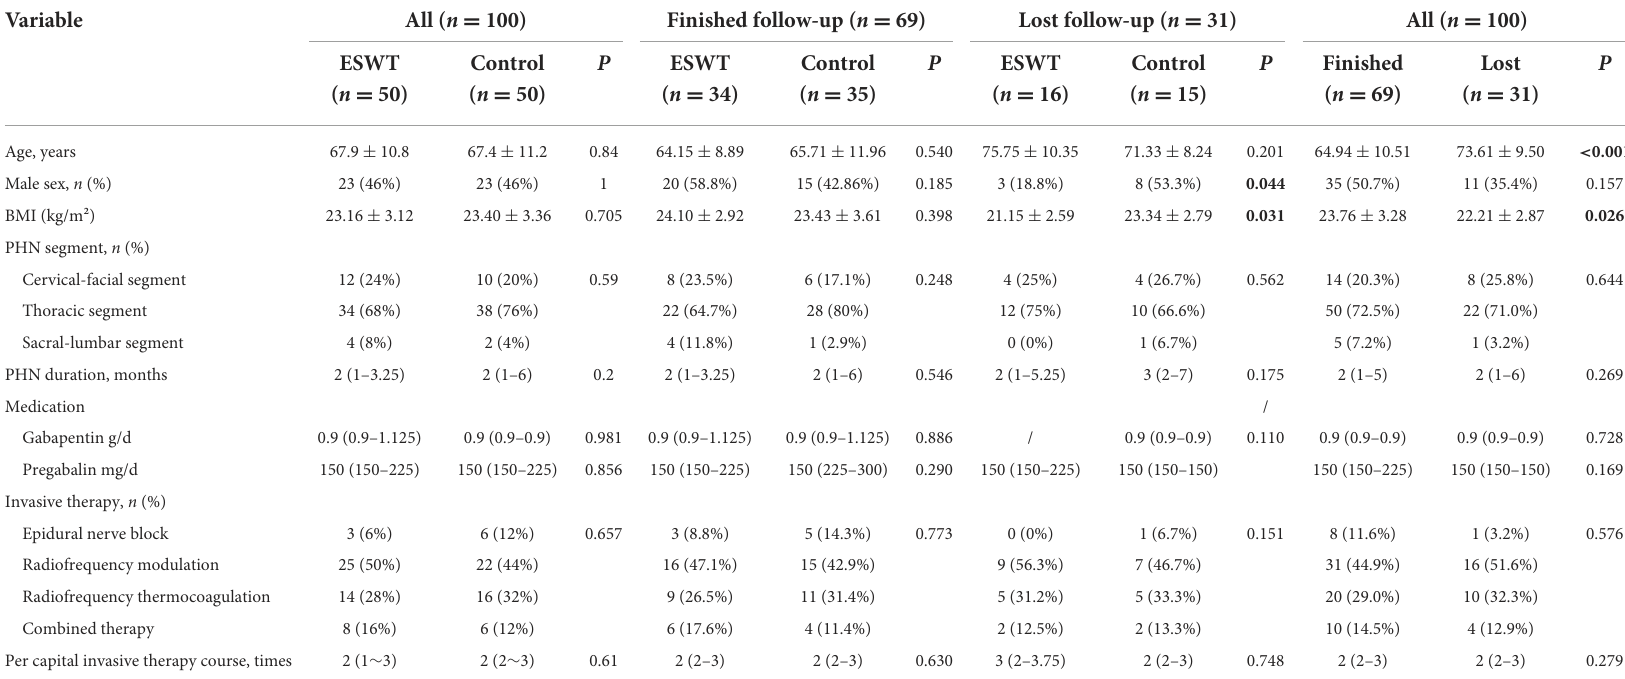
TABLE 2 Demographic and baseline characteristics of